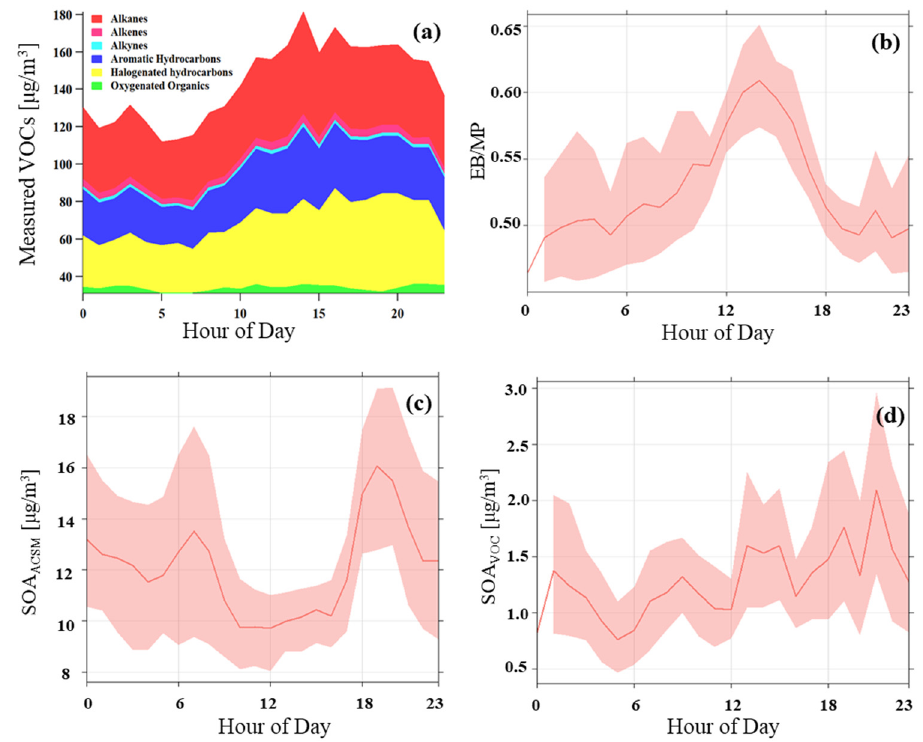
Figure 3. The diurnal variation of ( a ) Measured VOCs other than BVOCs; ( b ) the ratio of [EB] to [MP]; ( c ) SOA estimated from ACSM data; ( d ) SOA estimated by VOC oxidation. The pink area represents the 95% confidence interval.